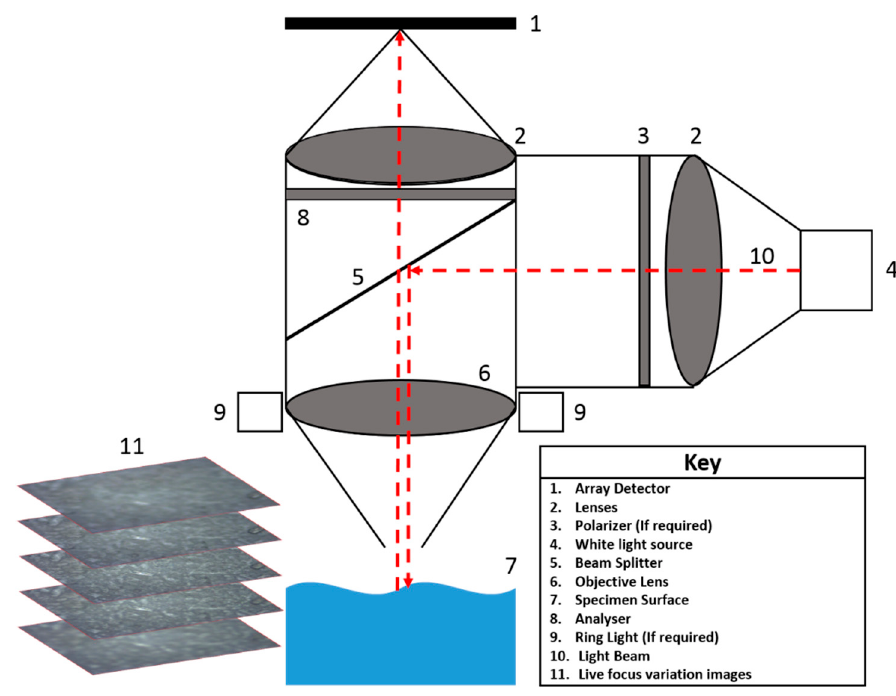
Figure 1. A schematic representation of a focus variation microscope and how this system varies focus to obtain topography information.